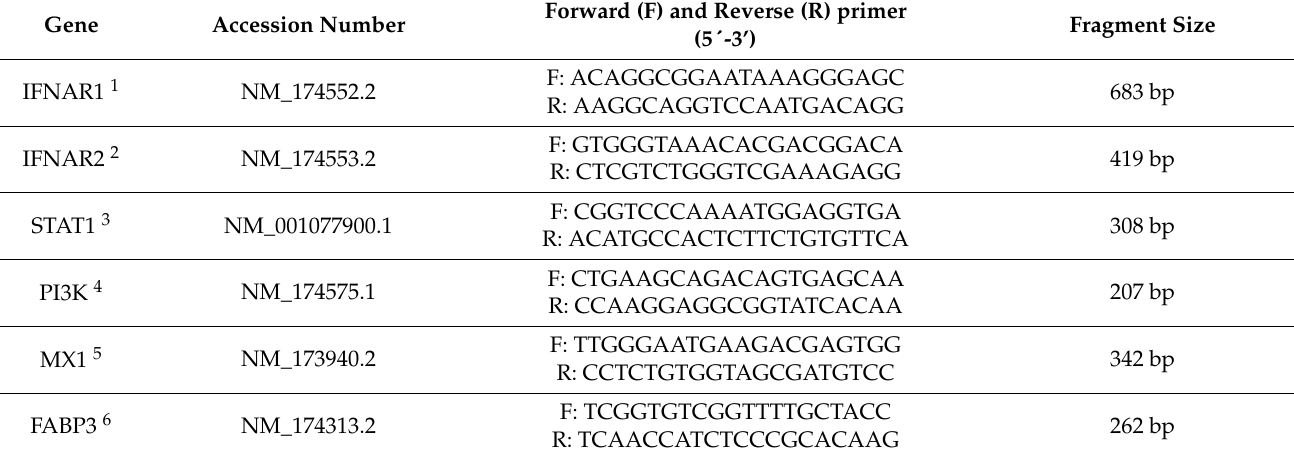
Table 1. Oligonucleotide primer sequences used in the quantitative real-time polymerase chain reaction (RT-qPCR) with the accession number and fragment size in base pairs